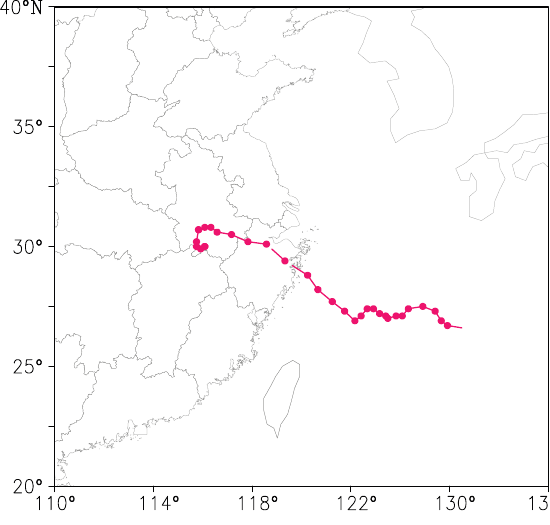
Figure 9. Observed Track of Haikui (1211).